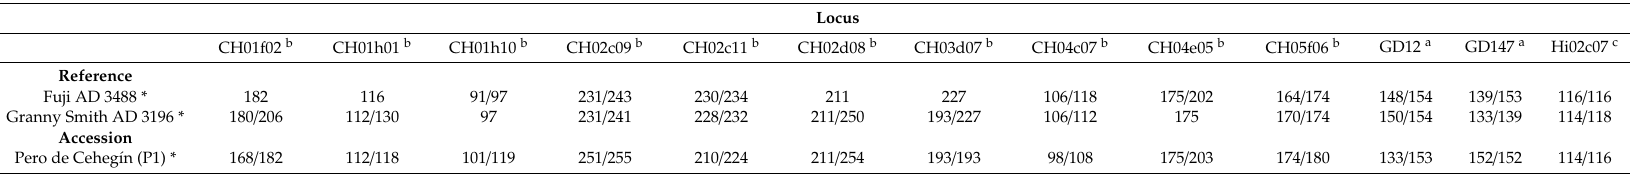
Table 3. Molecular profiles (allele sizes in base pairs) of “Pero de Ceheg í n” and two commercial varieties used as reference (“Fuji” and “Granny Smith”) obtained with 13 microsatellite